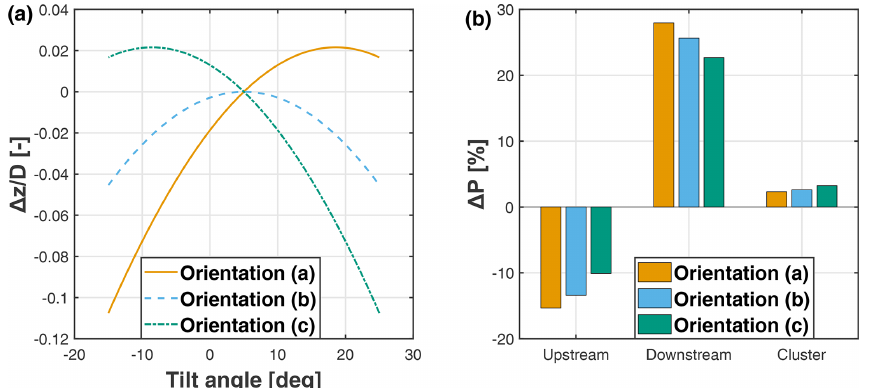
Figure 13. Normalized vertical translation of the rotor center as a function of the rotor tilt angle for three different turbine orientations (a) . Percent power change with respect to the baseline untilted case for a − 10 ◦ (wake-down) deflection at a 10 D downstream distance, for three orientations of the turbine with respect to the floater (b)